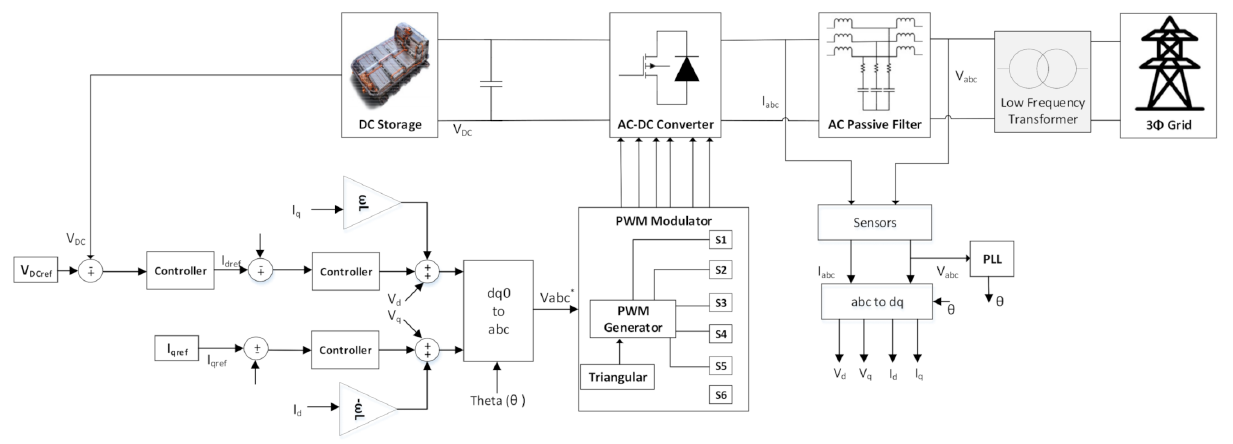
Figure 4. Classical dual-loop control of